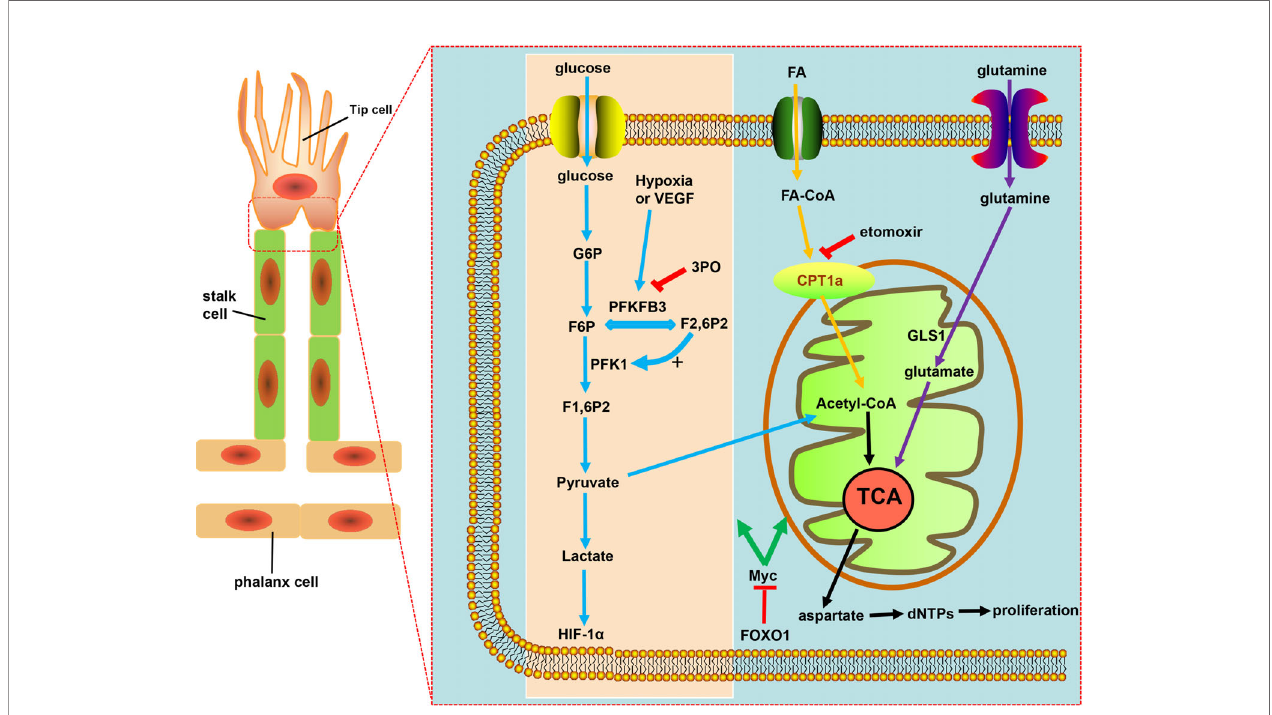
FIGURE 2 | Targeting EC metabolism promotes tumor vascular normalization. Glycolysis fuels the proliferating ECs. PFKFB3, overexpressed under hypoxia and vascular endothelial growth factor (VEGF) stimulation, is a key regulator of the glycolytic activity in ECs. F2,6P2, produced from F6P by PFKFB3, is the main allosteric activator of PFK1, which further increases glycolysis to produce ATP necessary for angiogenesis. PFKB3 inhibitor 3PO reduces pathological angiogenesis. CPT1a- driven FAO and glutamine metabolism both regulate angiogenesis by replenishing the TCA cycle and producing aspartate for nucleotides and DNA synthesis. CPT1a inhibition with etomoxir can promote tumor vessel normalization. FOXO1 keeps EC quiescence and vascular homeostasis via c-Myc regulation, ultimately resulting in decreased glycolysis and impaired mitochondrial